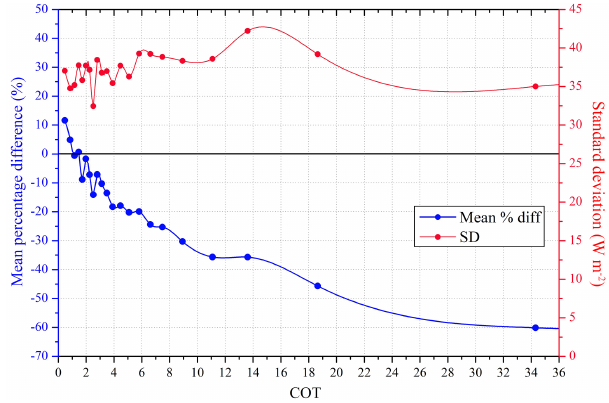
Figure 9. Mean percentage difference (blue) and standard deviation (red) of the 15min GHI produced from the MRF technique as com- pared to ground-based measurements from all stations as a function of the